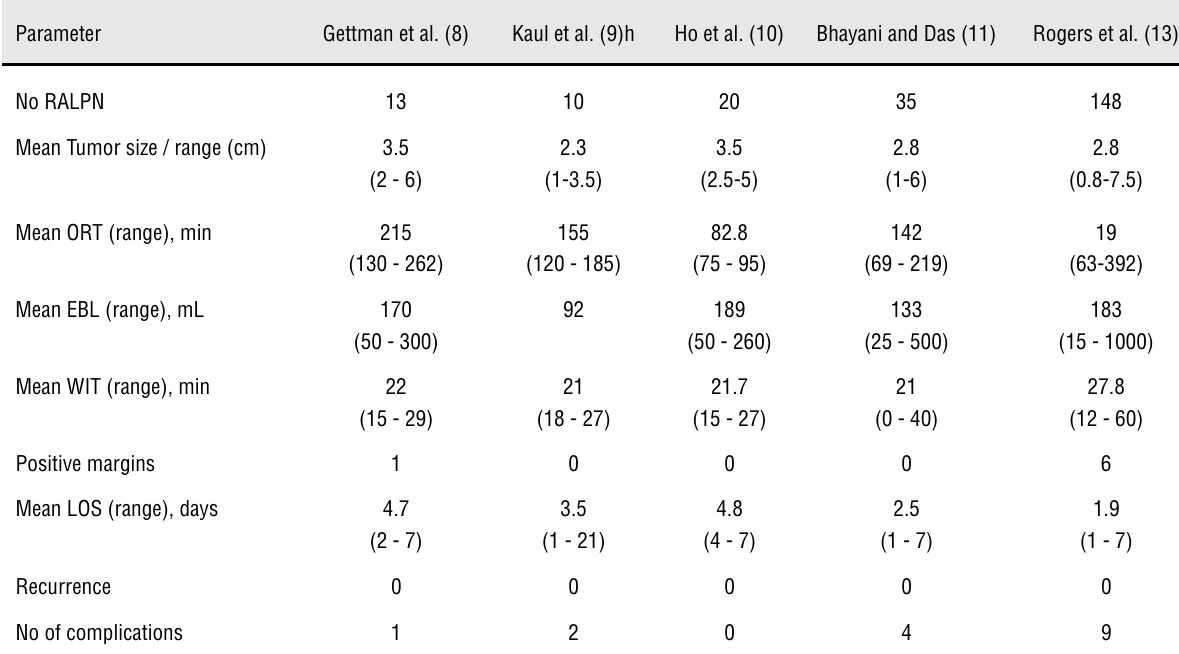
Table 4 - Initial RALPN series.